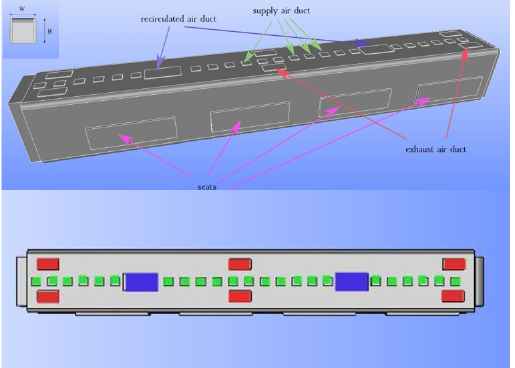
Figure 1. Schematic of a conventional urban subway car having supply air ducts, exhaust ducts, recirculated air ducts, and seats.